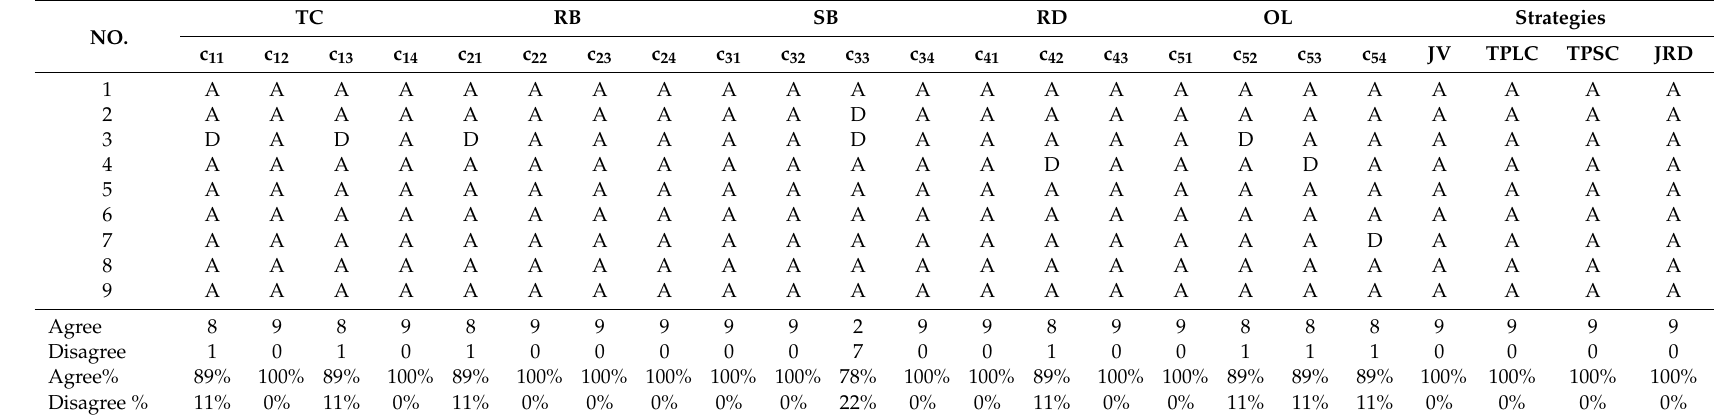
Table 3. Questionnaire collected of experts’